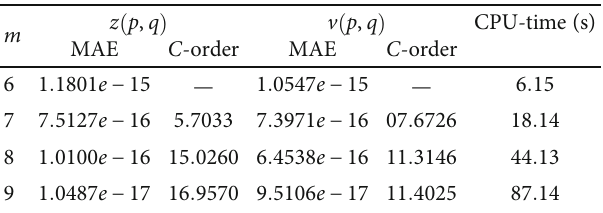
Table 6: The MA-error, C -order, and CPU time of the presented method in Example